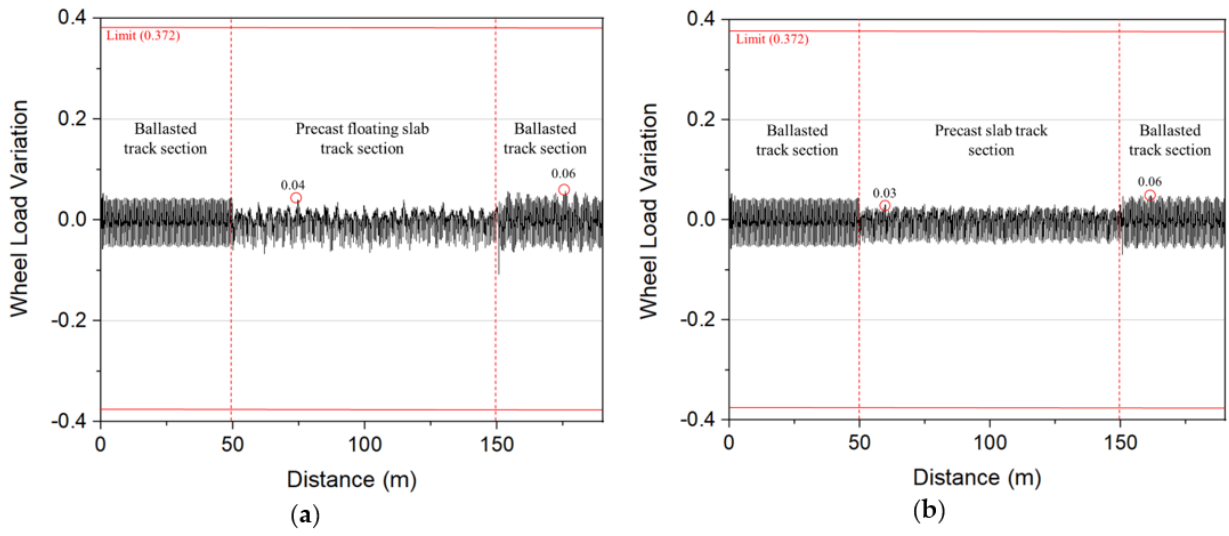
Figure 8. Wheel load variation results: ( a ) Precast Floating Slab Track (Type I), ( b ) Precast-Fast Improvement slab Track (Type II).